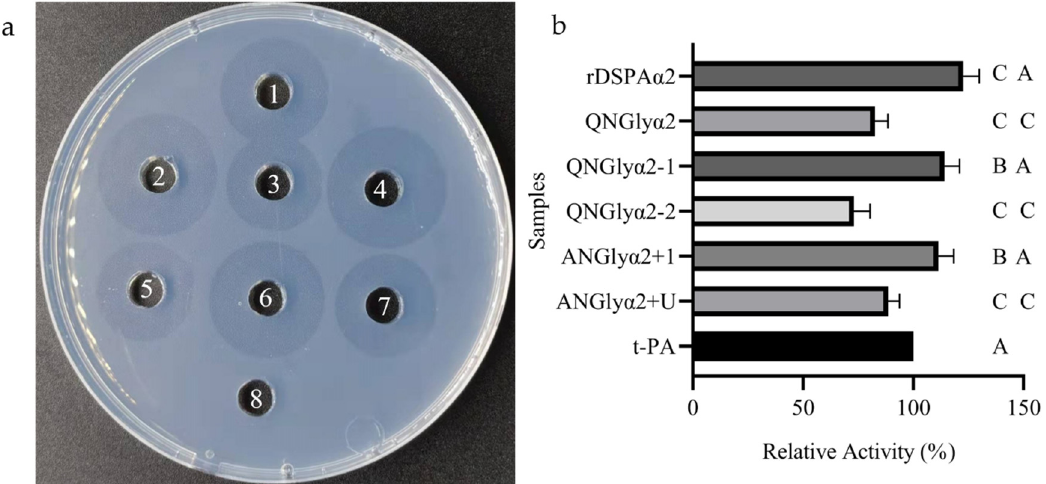
Figure 5. The fibrin assay and comparison of relative activity. ( a ) Results of the fibrin assay. Wells 1–8: t-PA, rDSPA α 2, QNGly α 2, QNGly α 2-1, QNGly α 2-2, ANGly α 2+1, ANGly α 2+U, and control (PBS), respectively. ( b ) The relative activity of the rDSPA α 2 and its mutants. The activity of all samples was compared to that of t-PA (10 U) to determine the relative activity, which is displayed in percentages. Values are mean ± SD of the three replicates. AB means 0.01 ≤ p ≤ 0.05, AC means p ≤ 0.01.